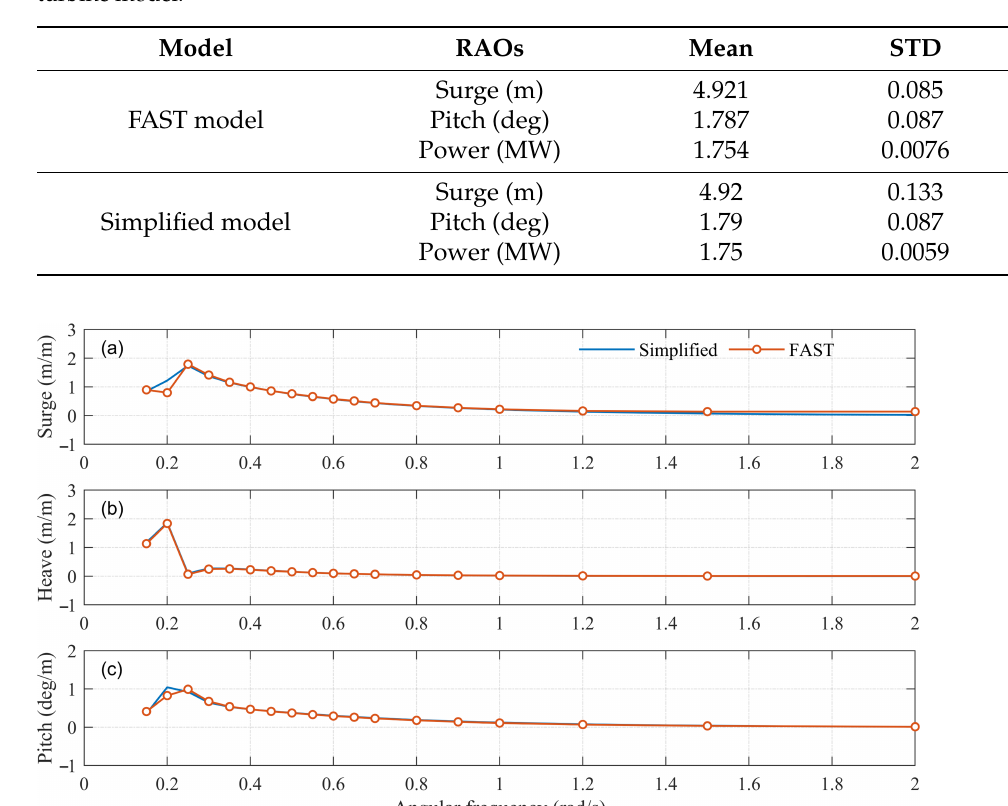
Figure 13. Frequency response of motion RAO for spar-buoy floater: ( a ) Surge; ( b ) Heave; ( c )